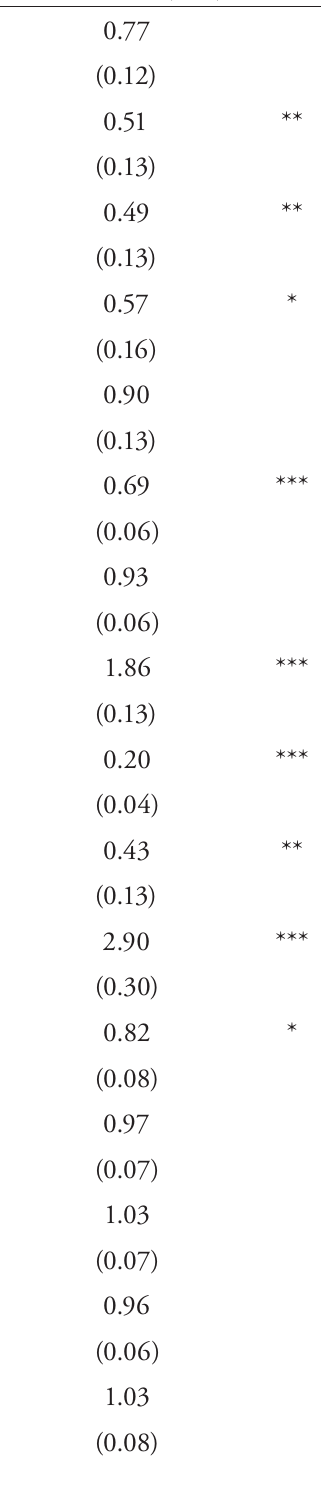
Table 2. Odds Ratios Predicting Student Graduation in Four Years at the End of the Fourth Year of College (n = 4,028)